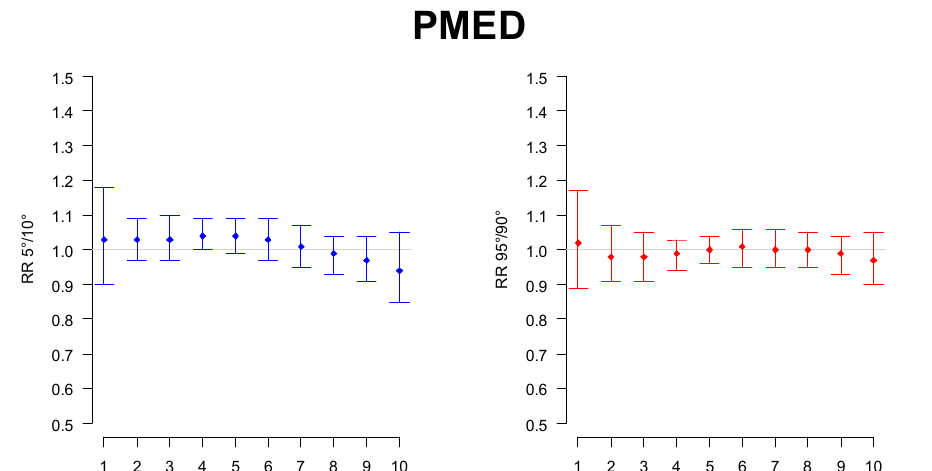
Figure 2. Relative risk of hospital admission in the lowest (“RR5vs10”, in blue) and highest tail of the variable distribution (“RR95vs90”, in red) for average atmospheric pressure.